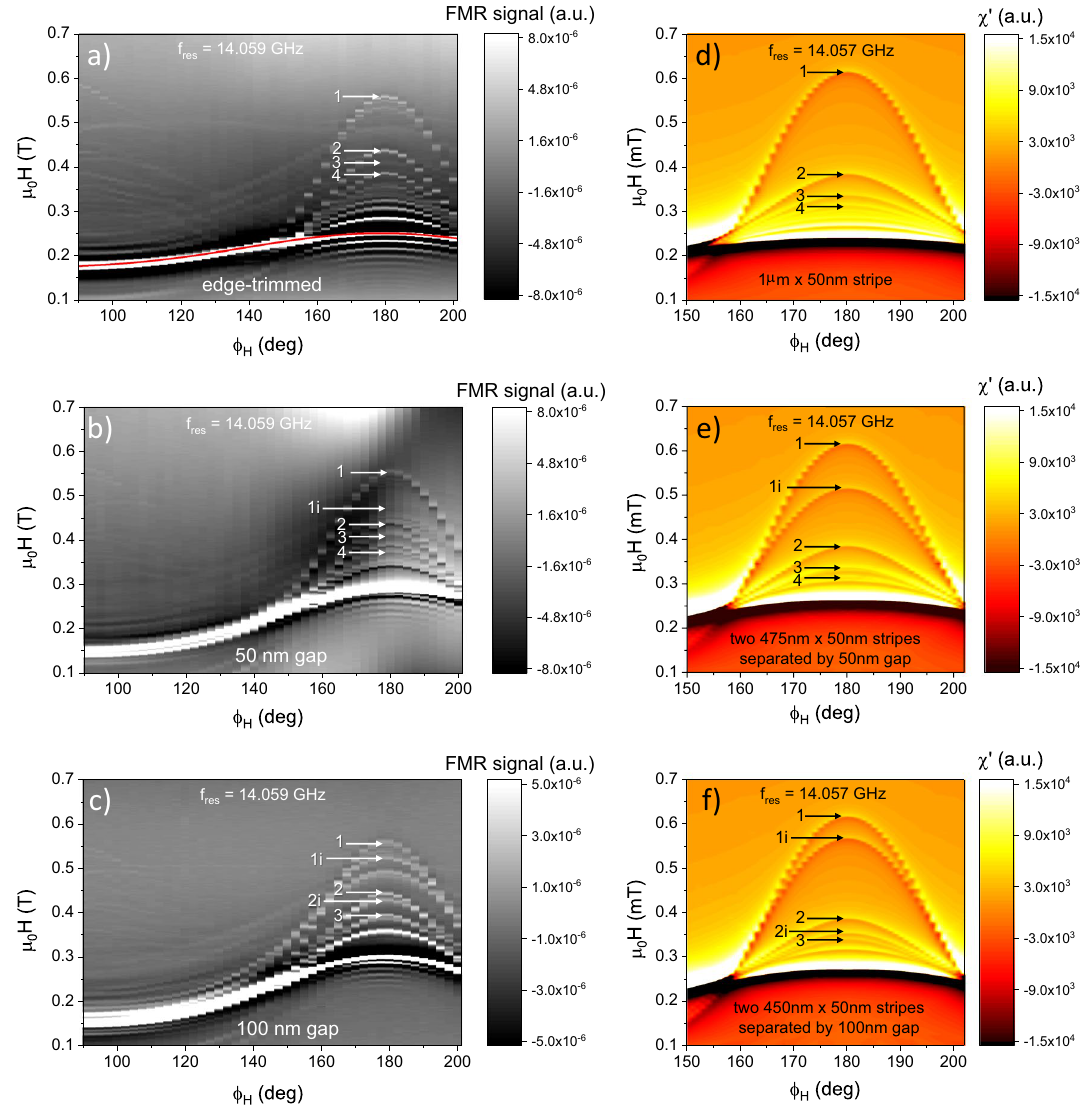
Figure 2. ( a – c ) In-plane angular dependences of the field-swept µ FMR signal measured at 14.059 GHz for ( a ) the edge-trimmed microstrip, ( b ) cut along in half using the Ne-FIB with a nominal gap of 50 nm, and ( c ) 100 nm. The red line in ( a ) shows the analytical fit to the measured data using the Kittel relation. The edge modes are numbered in the order of their appearance starting from the high field values (see text for details). ( d – f ) Corresponding µ FMR spectra of an infinitely long strip simulated for the excitation frequency of 14.057 GHz. ( d ) Infinitely long 1 - µ m -wide and 50-nm-thick strip, ( e ) two 475-nm-wide infinitely long strips separated by 50 nm, and ( f ) two 450-nm-wide strips separated by a 100-nm-wide